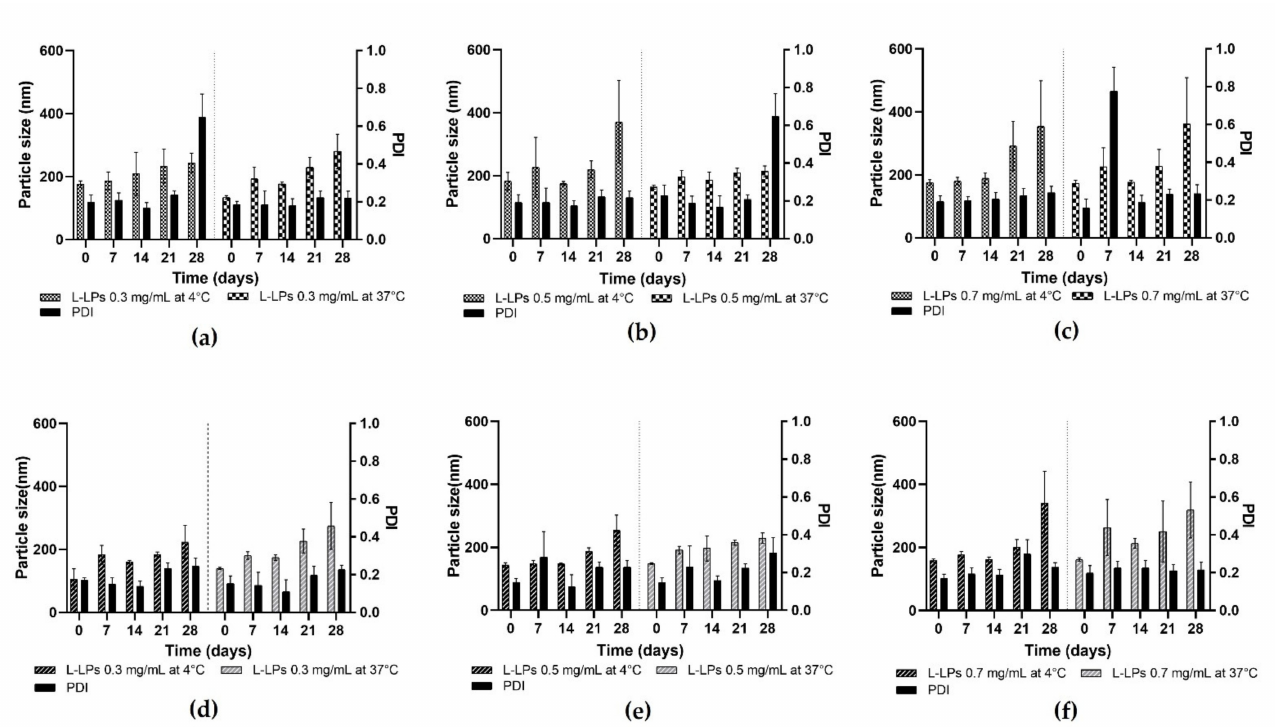
Figure 8. Stability profiles of L-LPs produced by device 1 and device 4. ( a – c ) Stability studies of 0.3, 0.5, and 0.7 mg mL − 1 L-LPs at 4 and 37 ◦ C using device 1; ( d – f ) 0.3, 0.5, and 0.7 mg mL − 1 L-LPs at 4 and 37 ◦ C using device 4. Results represent mean ± SD, n = 3 independent